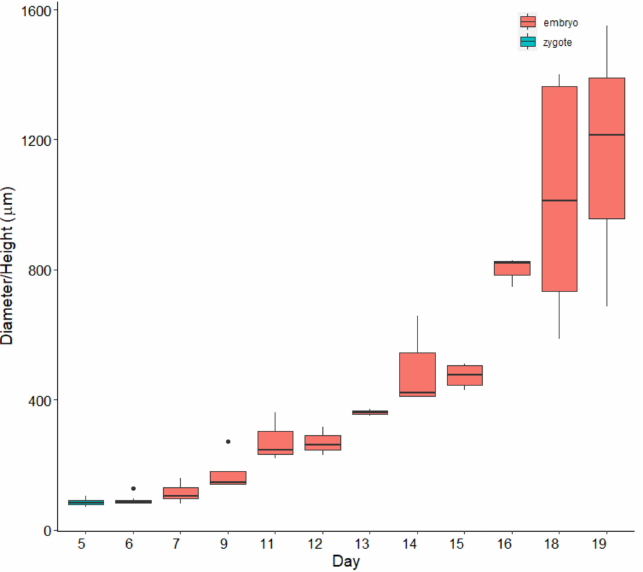
Figure 5. Gongolaria barbata zygote diameters (days 5 and 6) and embryo height (days 7 to 19) during laboratory cultivation. Coloured box represents interquartile range, central bar represents the median, vertical lines indicate the largest values within 1.5 times the interquartile range above the 75 ◦ percentile or the smallest below the 25 ◦ percentile, black points are values more than 1.5 times and less than 3 times the interquartile